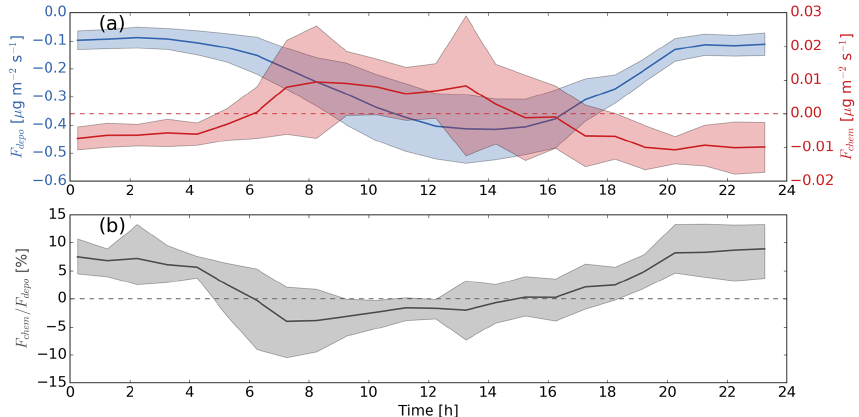
Figure 10. (a) The daily averaged (from 5 to 14 August) production and loss caused by chemistry ( F chem , red) and dry deposition ( F depo , blue). (b) The ratio between F chem and F depo . Zero lines for F chem and the ratio are plotted as dashed lines. Shaded areas show the range of ±